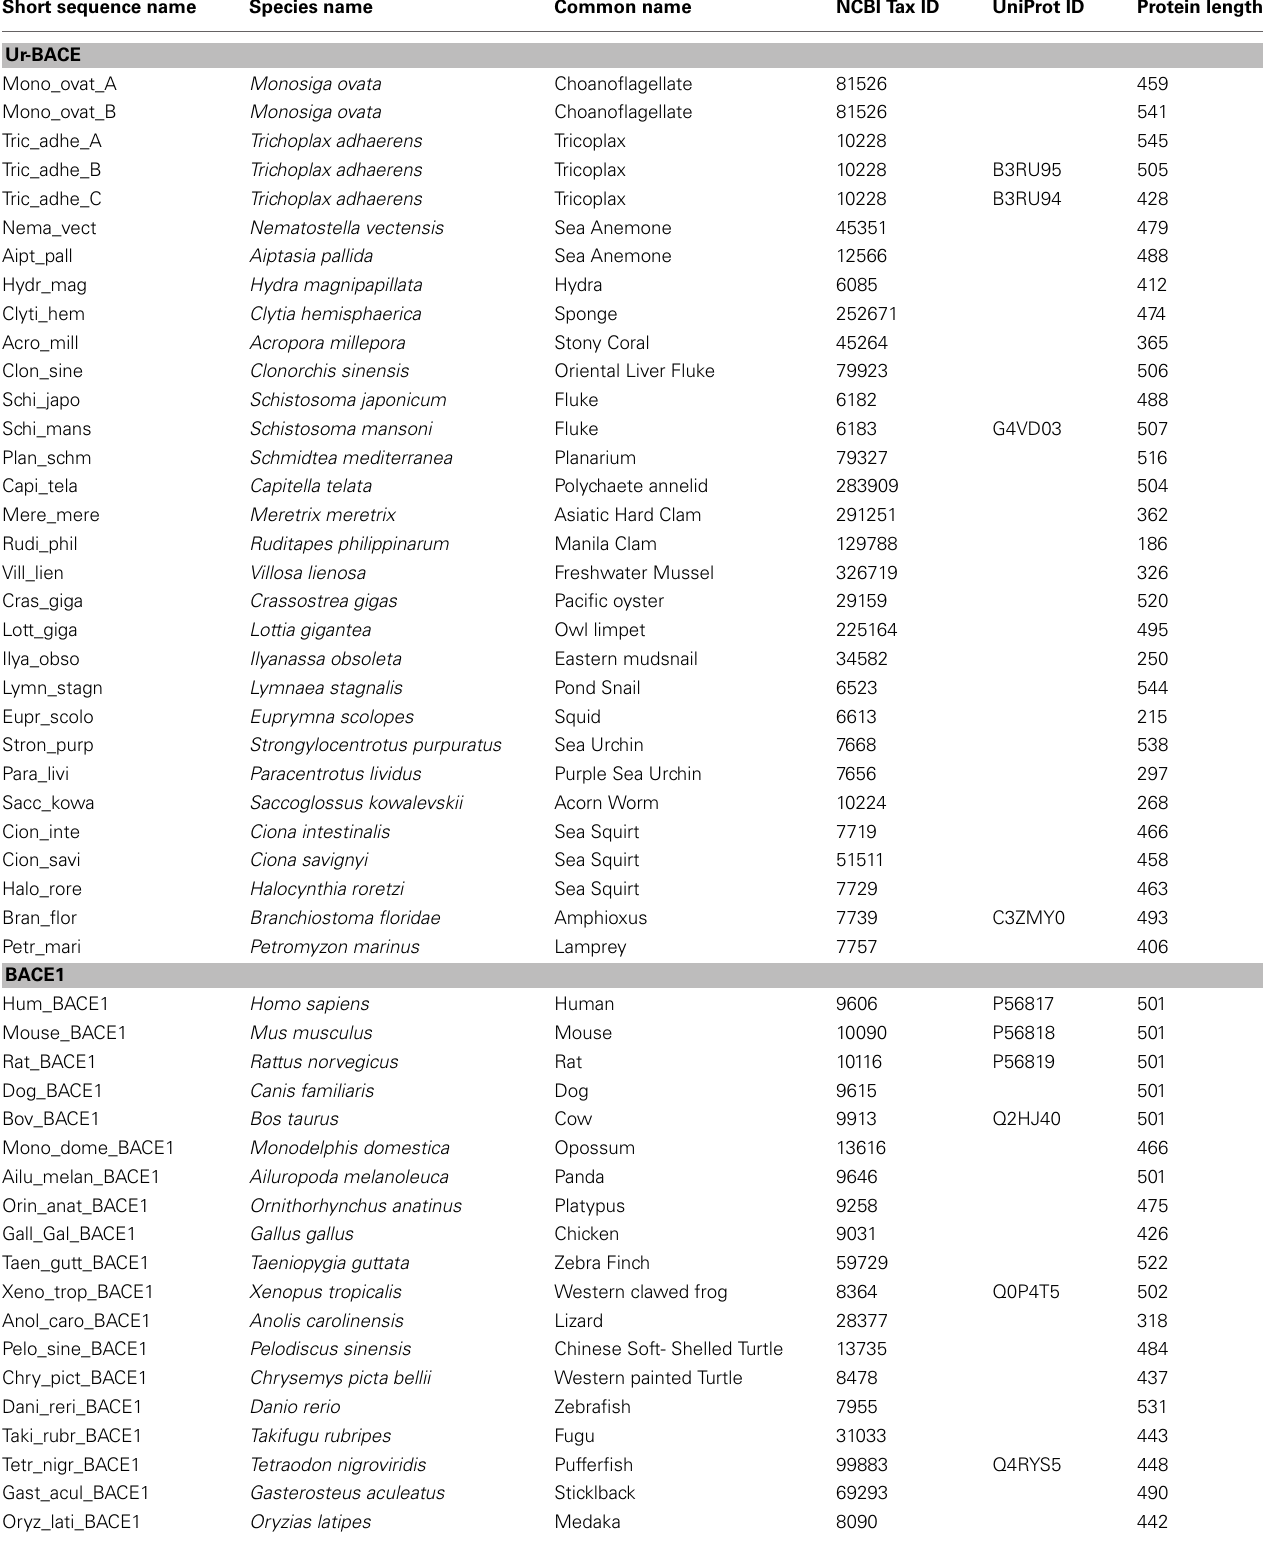
Table 2 | BACEs, BACE-like sequences and homologs used for phylogenetic